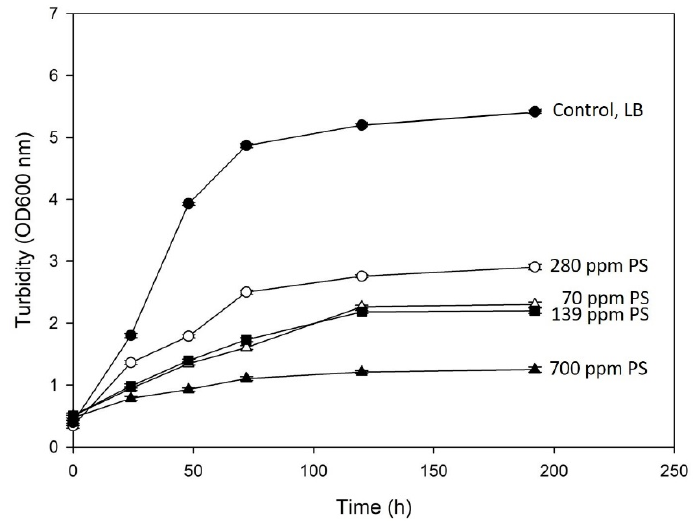
Figure 3. Growth curves were obtained from cultures of the bacterial consortium in the LB medium supplemented with different concentrations of PS. A culture in LB standard medium with no added PS served as the control. The numbers on the right side of each curve indicate the concentration (ppm) of PS added to each culture. The curve for each condition is the average of three replicates. Details of the LB standard culture medium preparation and cultivation procedure details are provided in the Materials and Methods section.